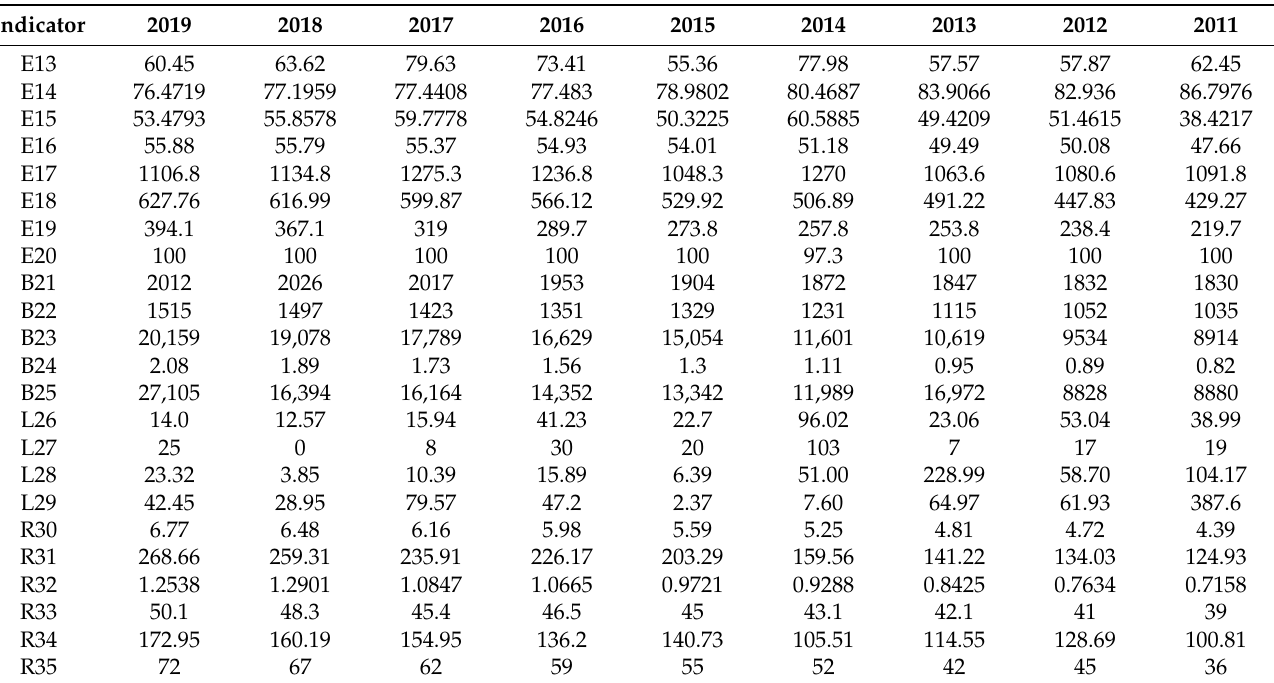
Table 6. Chongqing’s assessment results (2011–2019) of water security based on DPEBLR.